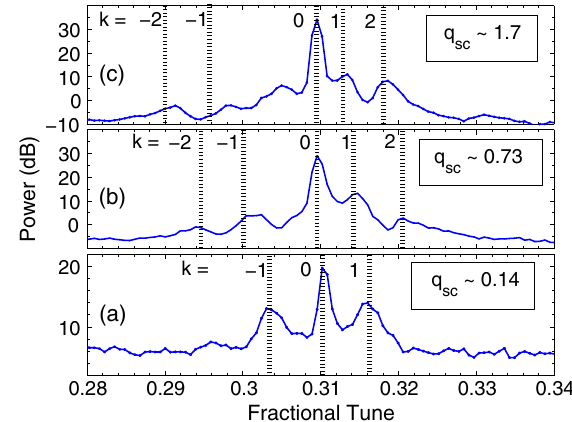
FIG. 9. Horizontal tune spectra for U 73 þ ions and beam pa- rameters given in Table I (see text). The dashed lines indicate the head-tail tune shifts from Eq. (8).